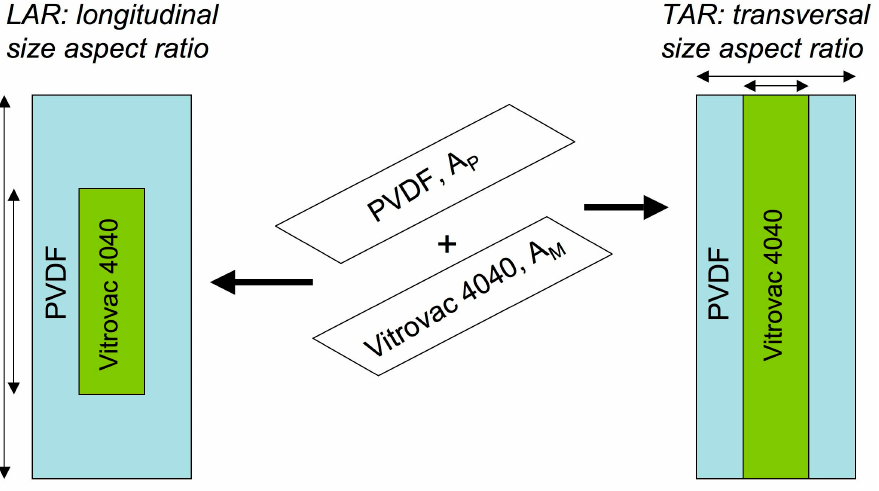
Figure 8. Graphical definition of the longitudinal size aspect (LAR) ratio and transversal size aspect (TAR) ratio between the PVDF and Vitrovac layers.